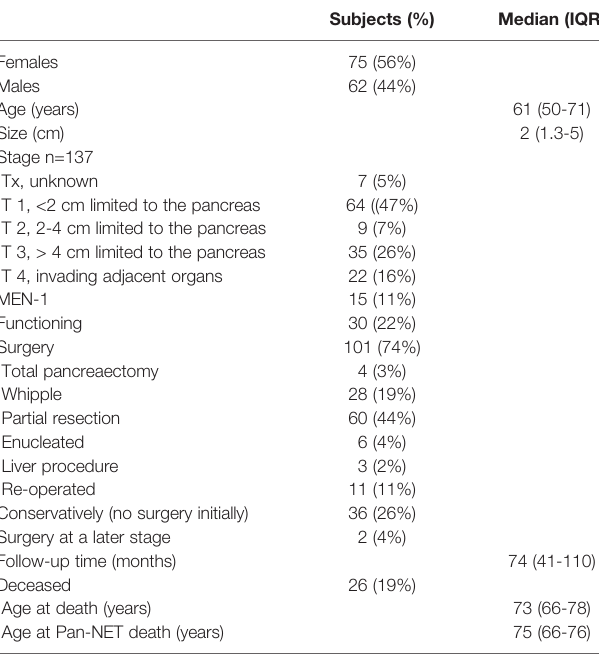
TABLE 1 | Summary of basal characteristics of 137 patients with pancreatic neuroendocrine tumors at time of diagnosis and follow-up.